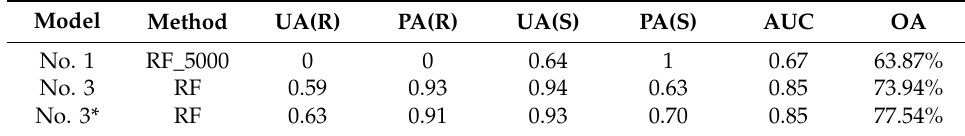
Table 6. Performances of the No. 1 model using the RF method with a cost of 5000 and No. 3 model with the RF algorithm, where OA, AUC, PA, UA, S, and R represent the overall accuracy, area under the ROC curve, producer’s accuracy, user’s accuracy, landslide source, and runout, respectively. Model Method UA(R) PA(R) UA(S) PA(S)